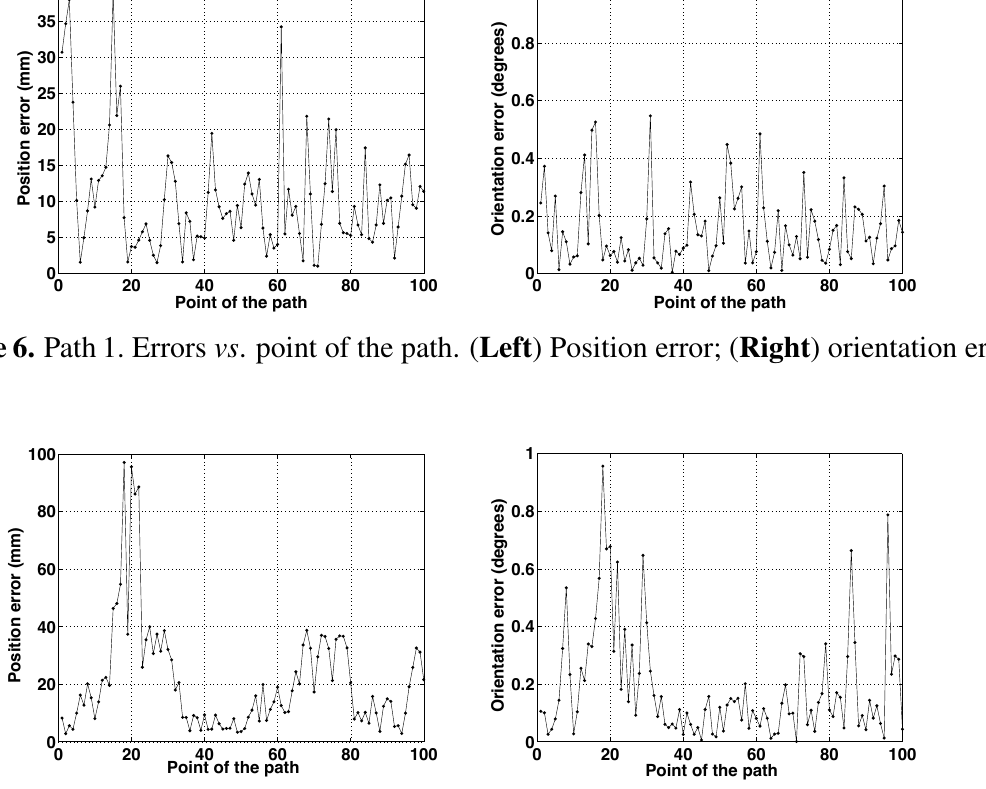
Figure 7. Path 2. Errors vs . point of the path. ( Left ) Position error; ( Right ) orientation